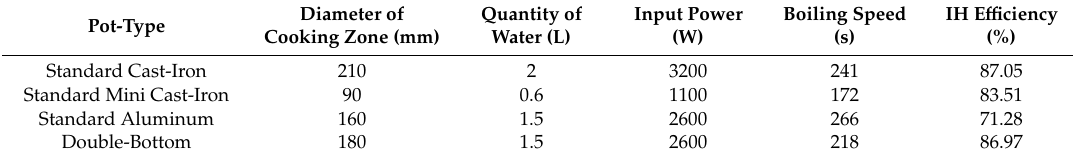
Table 5. Results of the proposed system for boiling-speed test and IH efficiency.